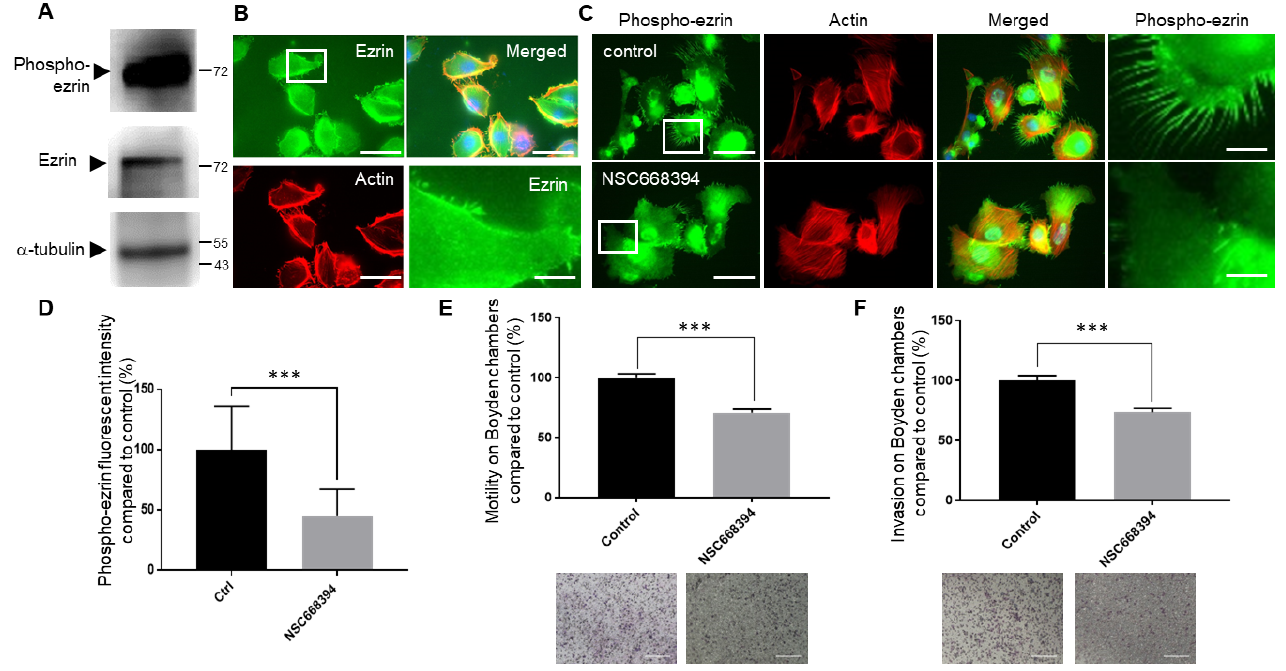
Figure 7. Inhibiting ezrin Thr567phosphorylation results in a significant reduction in both the cellular motility and invasion of human primary extravillous trophoblast cells. Human primary extravillous trophoblasts were grown for 48 h following isolation prior to either the collection of the protein lysates for Western blotting ( A ) or cell staining ( B , C ) or seeding for motility ( E ) or invasion ( F ). Cells were collected and solubilised in Lammeli buffer and equal loadings were separated by SDS-PAGE electrophoresis. Western blotting was carried out and membranes probed for ezrin, phosphor-ezrin Thr567, or α -tubulin, and cropped images are presented ( A ). For immunostaining, cells were seeded on fibronectin-coated coverslips and grown for 24 h prior to NSC668394 treatment. Cells were left to grow for a further 24 h prior to fixation, permeabilisation, and staining for ezrin ( B ), phospho-ezrin Thr567 ( C ), and actin ( B , C ). Cells were mounted and viewed using epifluores- cence microscopy. Images in the last row correspond to the focused regions of the highlighted cells. Bar corresponds to 50 μ m in the wide views and 10 μ m in the zoomed-in regions. Expression levels of Thr567-phosphorylated ezrin in human primary extravillous trophoblasts treated with NSC668394 inhibitors for 24 h by immunofluorescence ( D ) and presented as intensity percentage mean values ± SD of 3 independent samples of a representative experiment compared to non-treated control samples. *** p < 0.001 (one-way ANOVA). For motility and invasion, cells were starved with